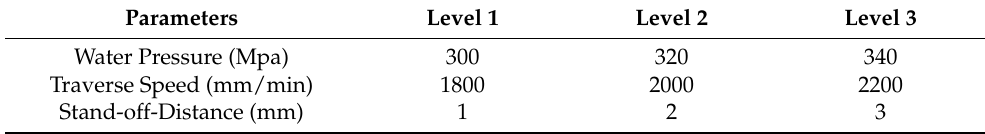
Table 5. Input parameters levels for specimen thickness of 4 mm, in the abrasive waterjet cutting process.